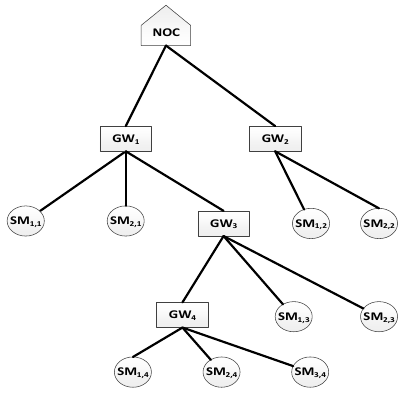
Figure 3. Authentication for Group Gateway.